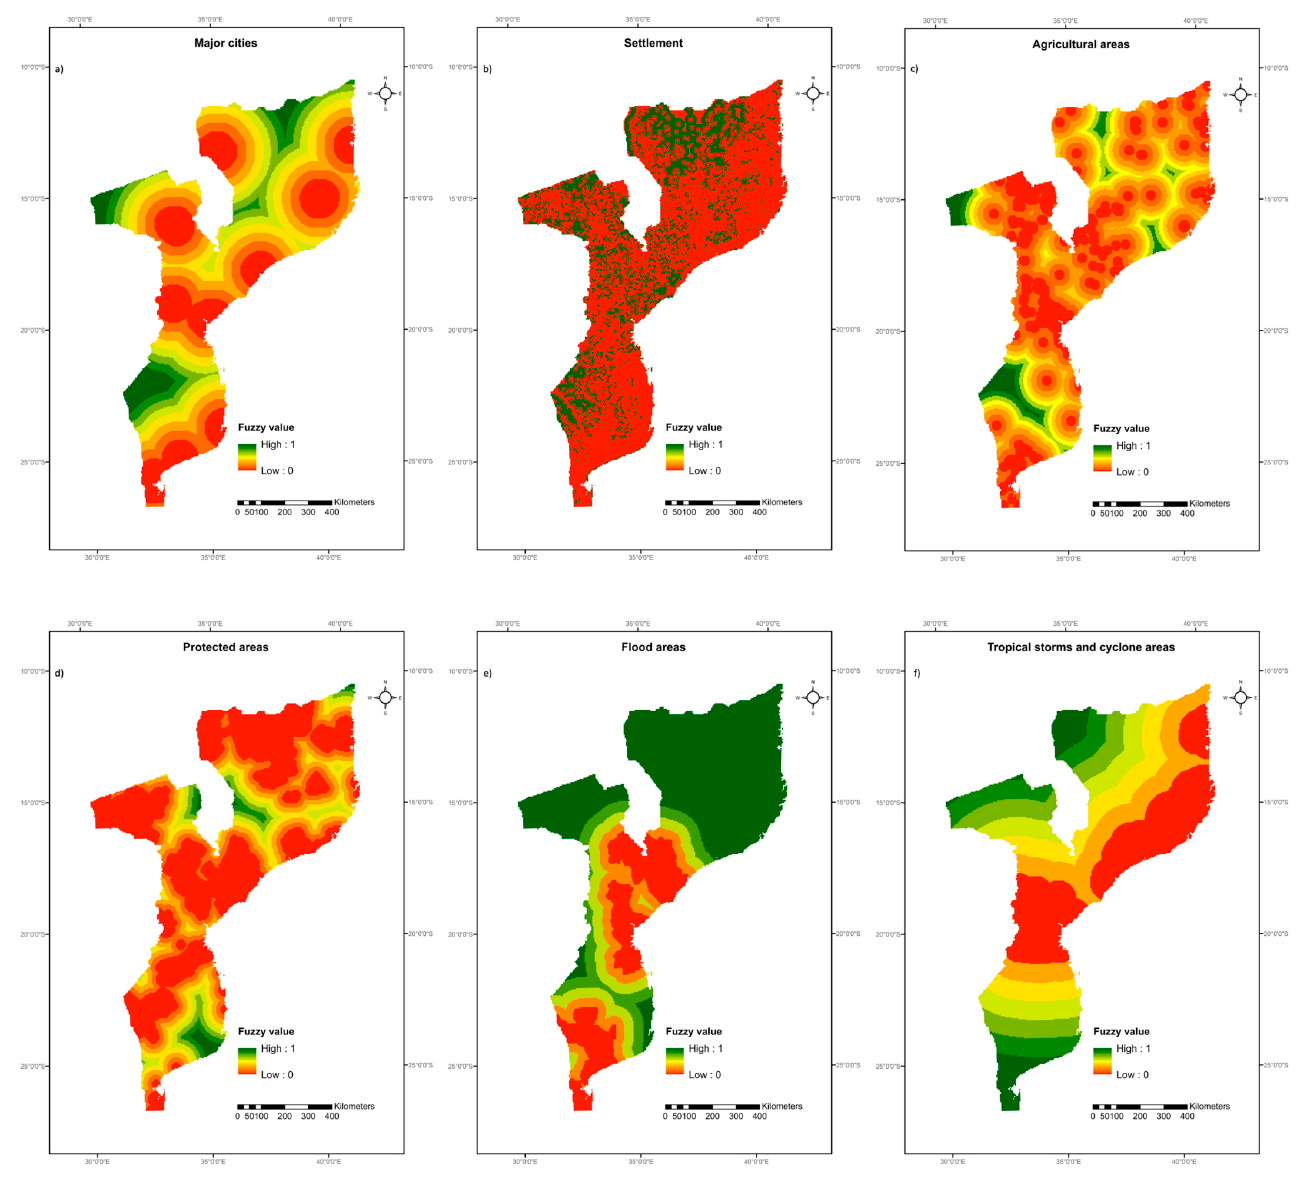
Figure A6. Standardized (reclassified and fuzzified) raster maps of location restriction applied to the spatial suitability of off-grid solar PV microgrid projects in Mozambique. ( a ) Major cities, ( b ) settlements, ( c ) agricultural areas, ( d ) protected areas, ( e ) flood areas, and ( f ) tropical storms and cyclone areas.